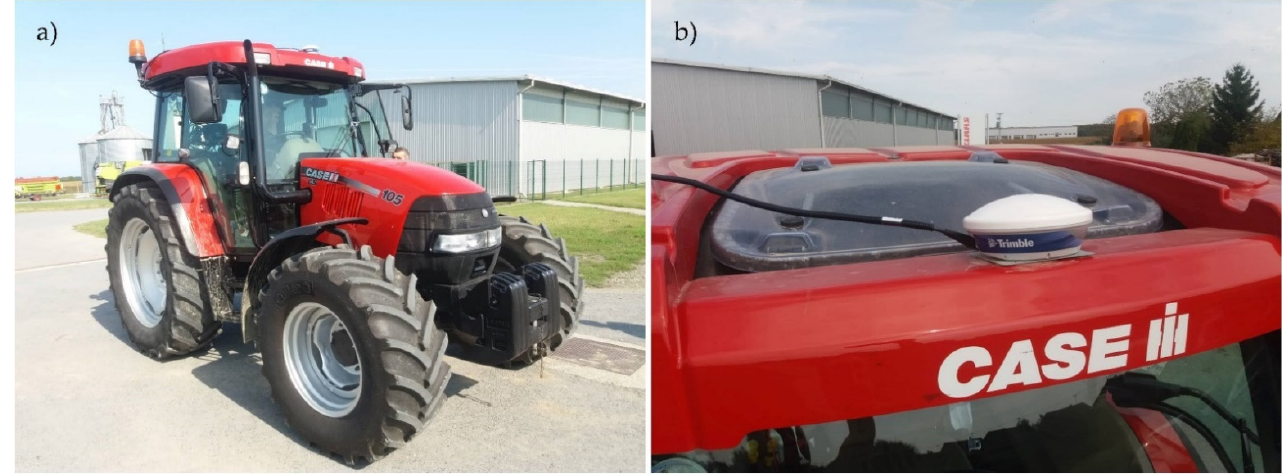
Figure 2. The equipment used for the research: ( a ) Case IH CS 105 PRO agricultural tractor, ( b ) Trimble Ag25 GNSS receiver with the CFX-750 controller.